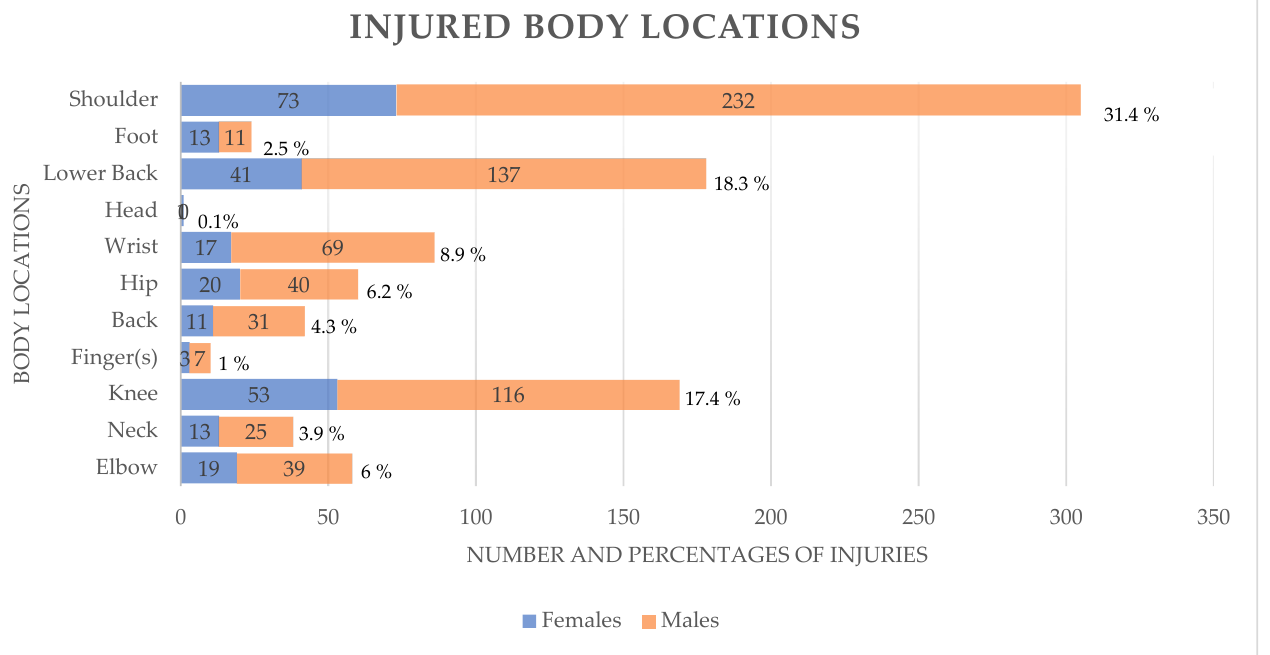
Figure 1. Injured Body Locations Graph.